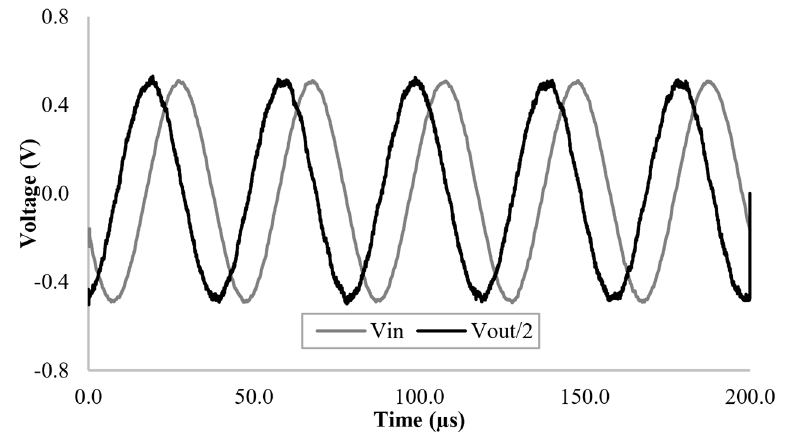
Figure 19. Measured time-domain analysis of the grounded simulated inductor.